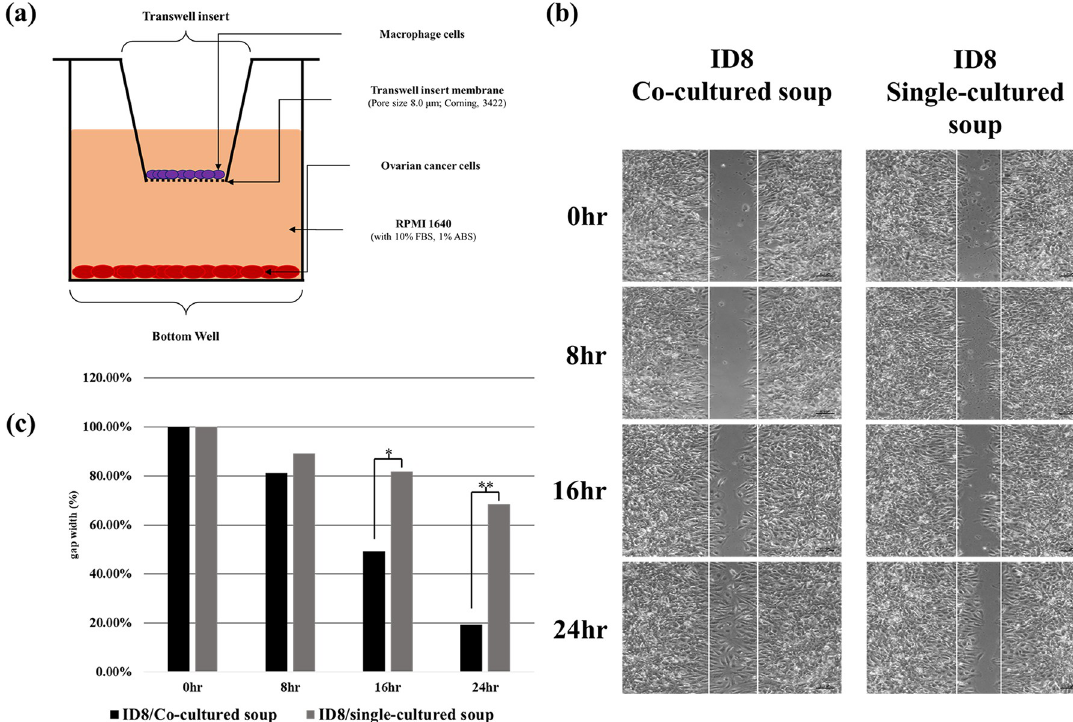
Fig 1. Schematic representation of the co-culture and wound healing assays with or without macrophages. (a) Depiction of the co- culture assay. (b) Representative images of the wound healing assay at 0, 8, 16, and 24 h time points. (c) Graphical representation of the wound healing assay results. Data are presented as the mean ± SEM of values from four independent experiments. � p < 0.001, �� p <